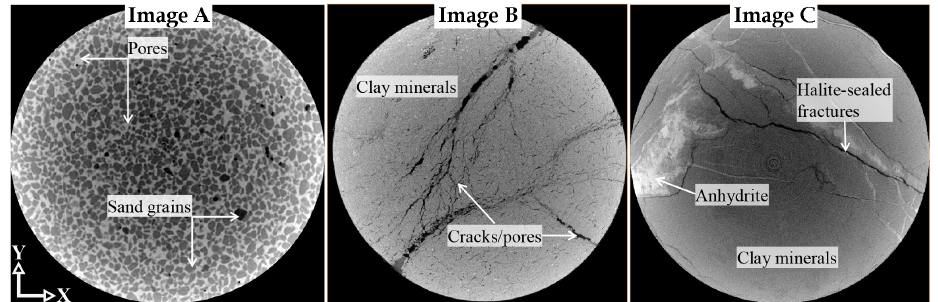
Figure 3. Reconstruction of a µ XCT image of computational domain sizes of (A) a 16bit image of 1327 × 1212 dimensions with each pixel length 5.9µm of a sand-filled Plexiglass tube, and of (B, C) 8bit images of dimensions 1600 × 1600 and 1417 × 1417 pixels of two different rock cores (42µm per pixel).